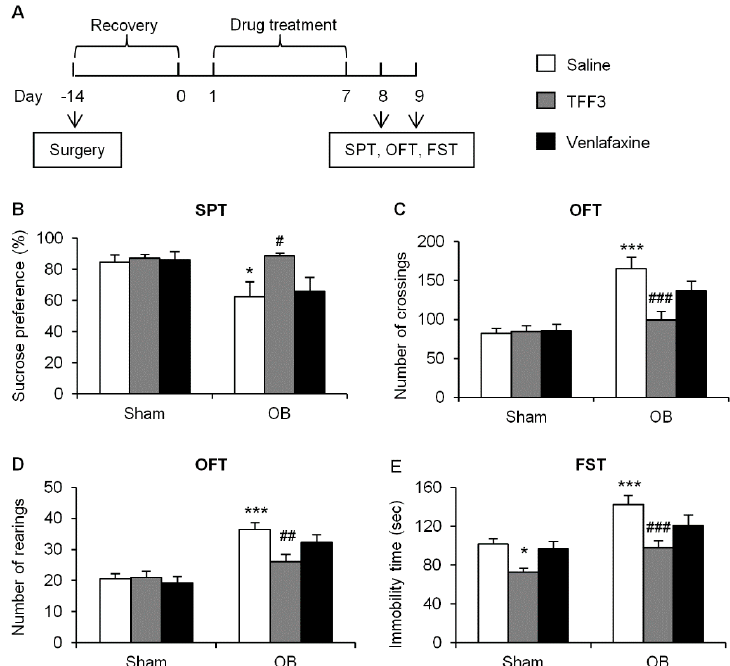
Figure 1. Chronic trefoil factor (TFF) 3 treatment produced antidepressant-like effects in olfactory bulbectomy (OB) rats. ( A ) Timeline of the experimental procedures. Decreased sucrose preference ( B ) in the sucrose preference test (SPT), increased crossings ( C ), and increased rearings ( D ) in an open field test (OFT), and increased immobility time ( E ) in the forced swim test (FST) were induced by the OB procedure but 7-day TFF3 treatment reversed the deficits. The data are expressed as mean ± SEM ( n = 9 per group). * p < 0.05, *** p < 0.001, compared with sham-saline group; # p < 0.05, ## p < 0.01, ### p < 0.001, compared with OB-saline group.